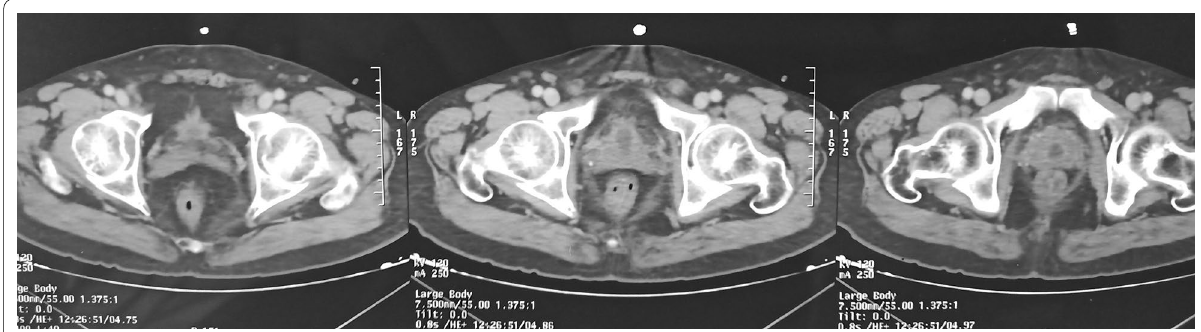
Fig. 1 CECT whole abdomen showing right small kidney and left normal kidney with bilateral PCN in situ with thimble bladder